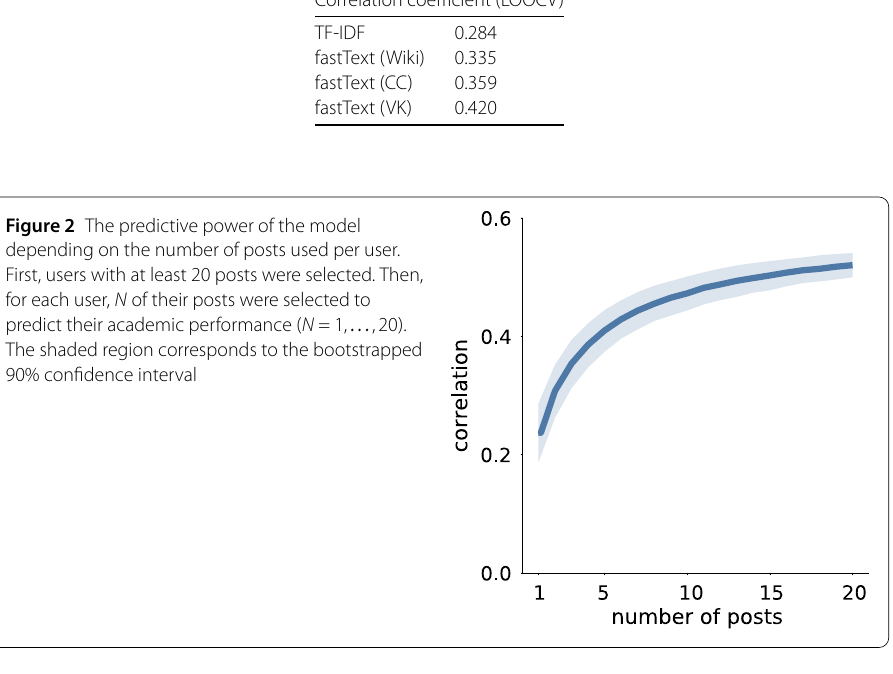
Table 1 Predictive power of the models measured as Pearson correlation between real and predicted outcomes. The results were computed using leave-one-out cross-validation